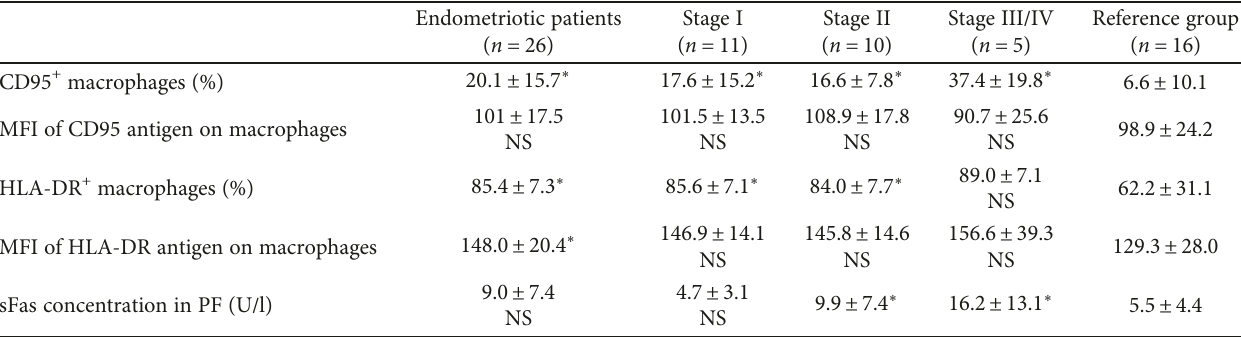
Table 2: Soluble form of Fas (sFas) antigen concentration in peritoneal fl uid and percentage of macrophages expressing CD95 (CD95 + ) and HLA-DR (HLA-DR + )